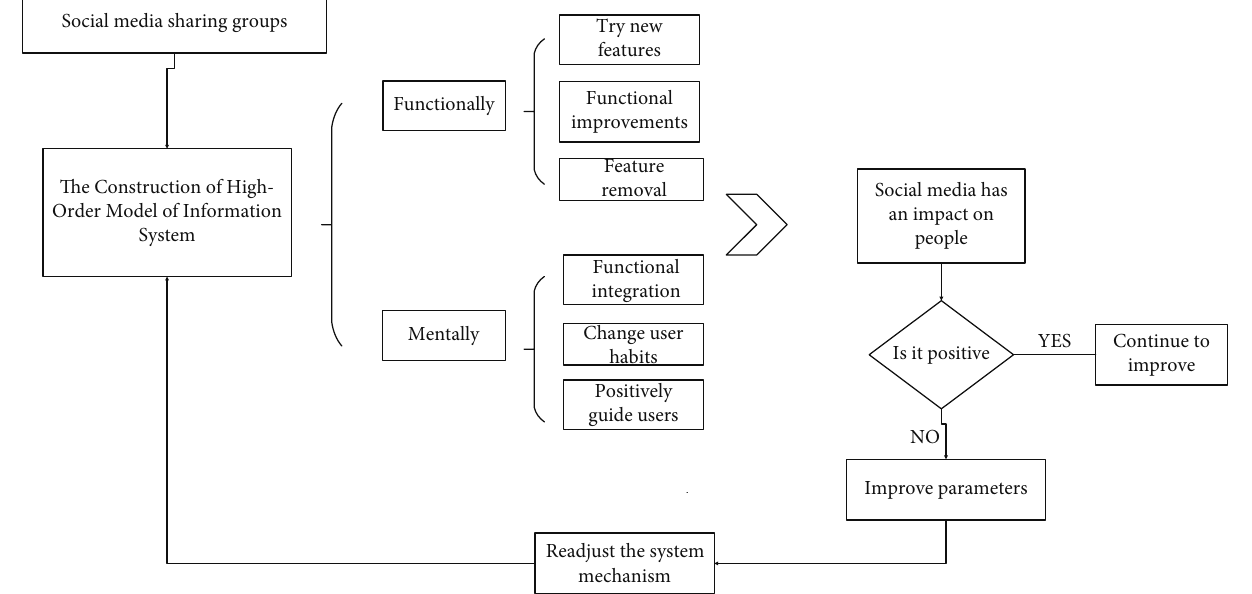
Figure 1: IT implementation process and usage stages.